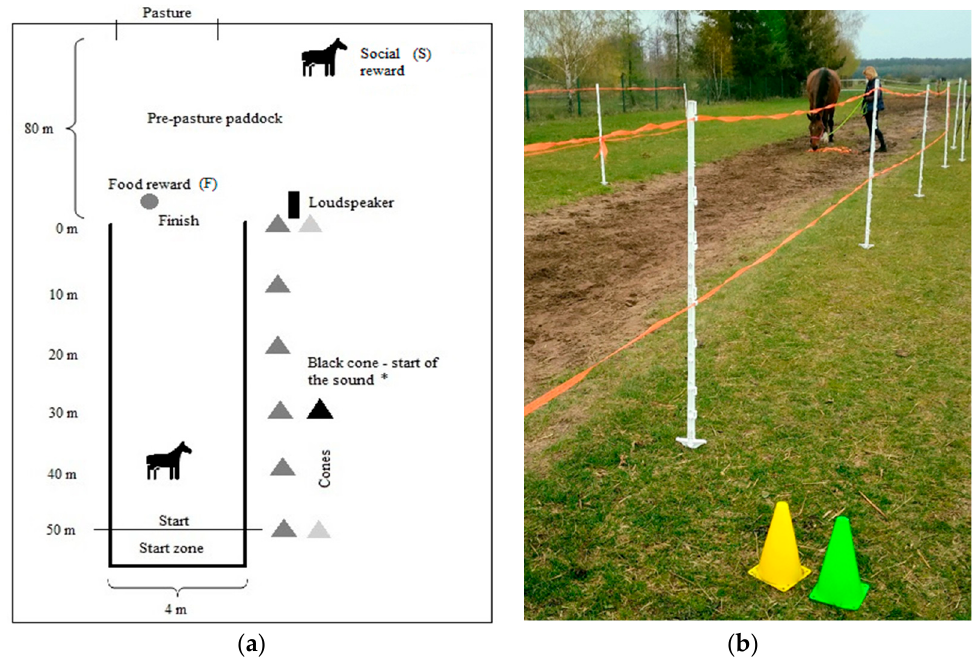
Figure 1. ( a ). The outline of a sound tunnel and an experimental paddock. (F), (S)—the first and second variants of the study (two separate tests); cones—subsequent 10 m distances from the loud ‐ speaker (two cones at the start and finish); black cone—positioned 30, 15 or 5 m from the finish